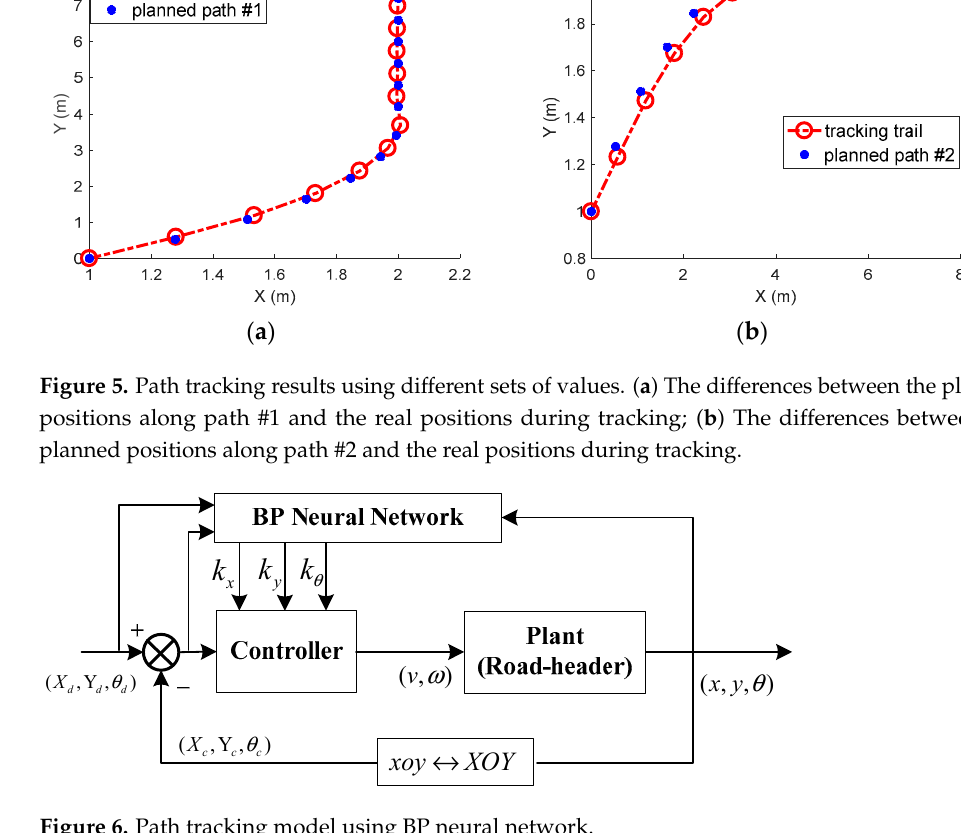
Figure 6. Path tracking model using BP neural network.